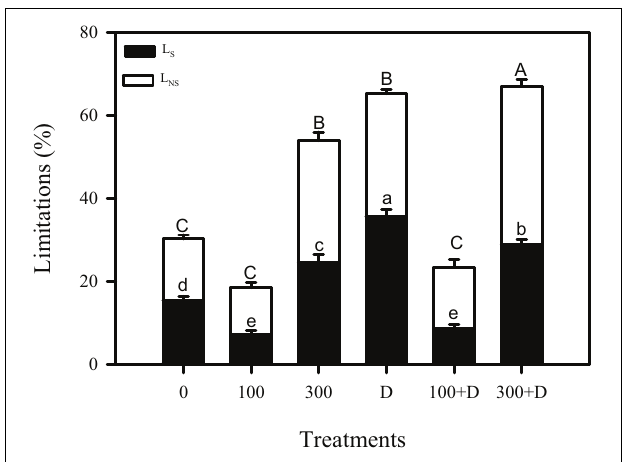
FIGURE 5 | Contribution of limitation in photosynthesis estimation. Dark and white bars represent stomatal limitation ( L S ) and non-stomatal limitation ( L NS ), respectively, in the leaf of Panicum antidotale under treatments of 0, 100, and 300 mM NaCl, drought (D), and a combination of salinity with drought [100 and 300 mM NaCl + drought (100 + D and 300 + D, respectively)]. Different letters denote, after Bonferroni post hoc test, significant difference ( P <